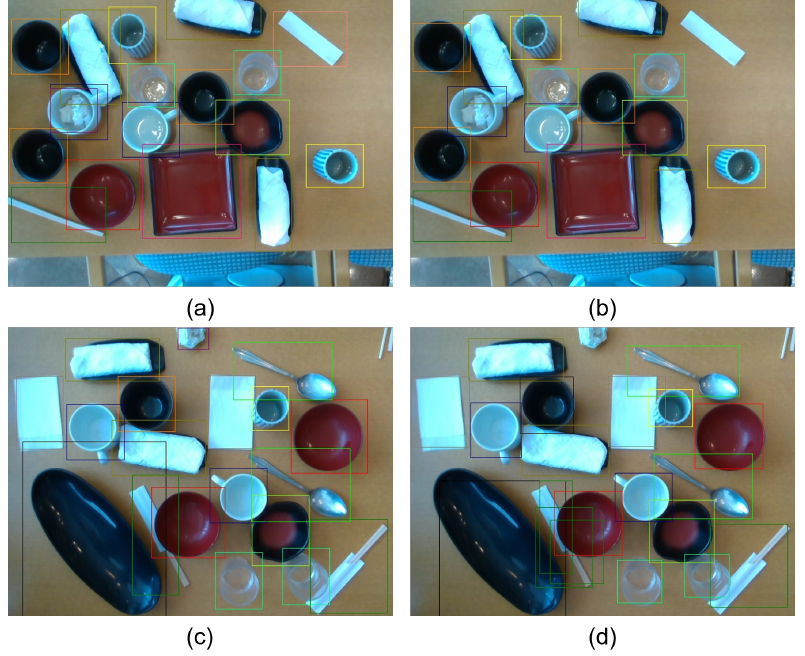
Figure 7. Examples about the effect of the reduced accuracy after pruning. ( a ) detection results of testing image A using original model, ( b ) detection results of testing image A using pruned model, ( c ) detection results of testing image B using original model, ( d ) detection results of testing image B using pruned